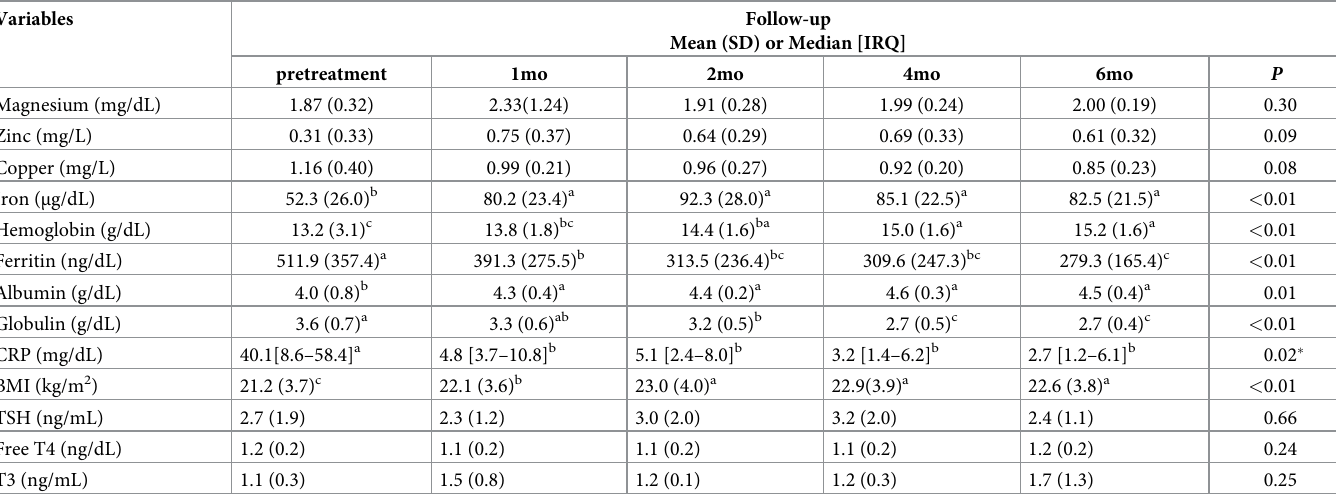
Table 4. Serum levels of minerals, proteins, thyroid hormones and body mass index (BMI) of 14 patients with paracoccidioidomycosis (PCM group) before and during PCM treatment.